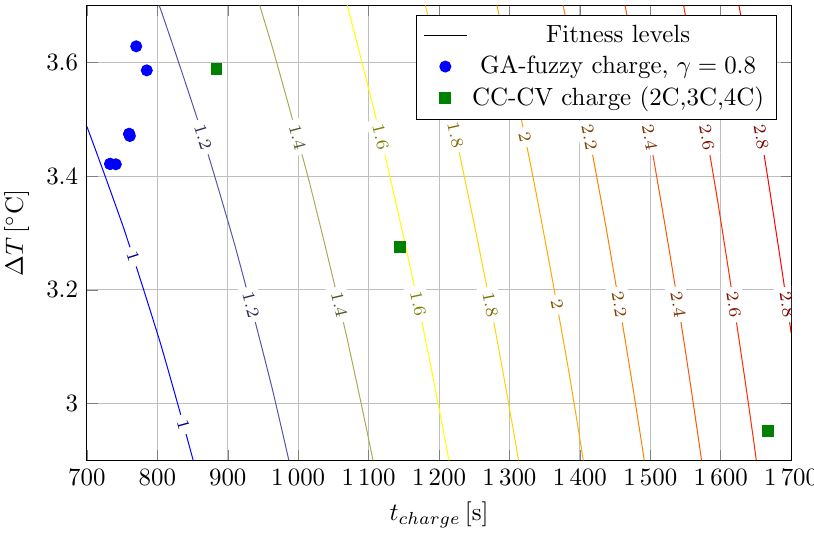
∆ T plane for γ = 0.8. −